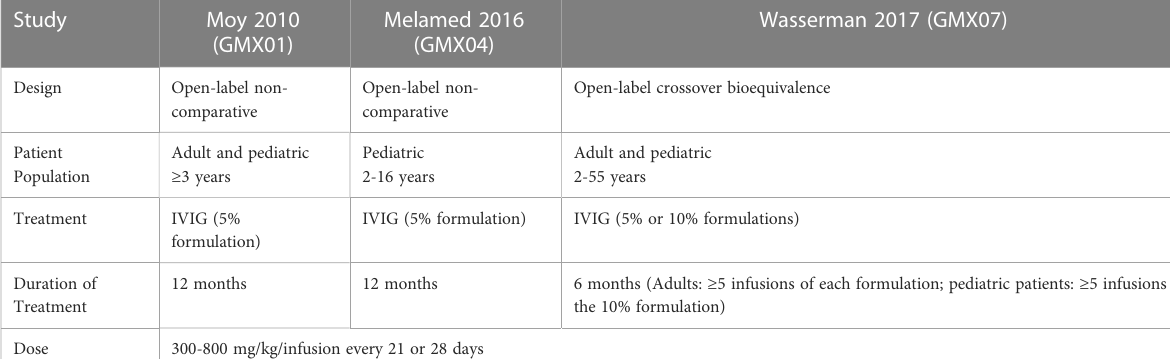
TABLE 1 Characteristics of the pooled trials (18 – 20).